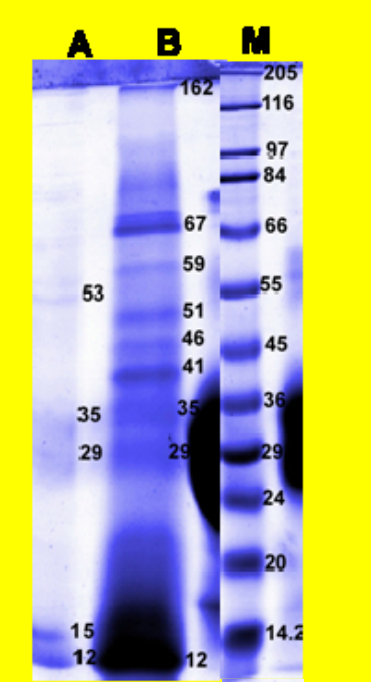
Figure 3. SDS-gel electrophoresis of Androctonus crassicauda venom. Lane A: venom obtained by electric stimulation; Lane B: venom obtained by maceration of telsons; Lane M: molecular weight markers – 205kDa (Myosin), 116kDa ( β - Galactosidase), 66kDa (Albumin), 45kDa (Ovalbumin), and 14.5kDa ( α